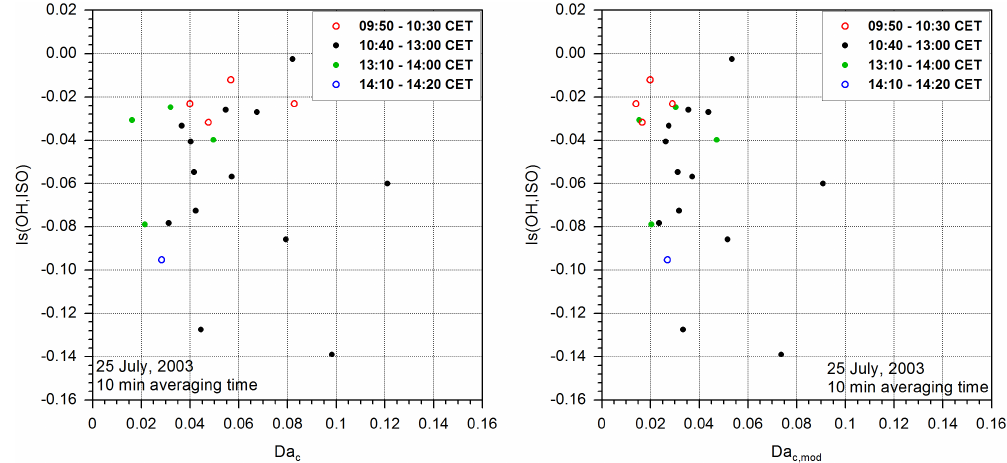
Figure 21. I S as a function of Damköhler numbers Da c (left) and Da c by modelled OH mod